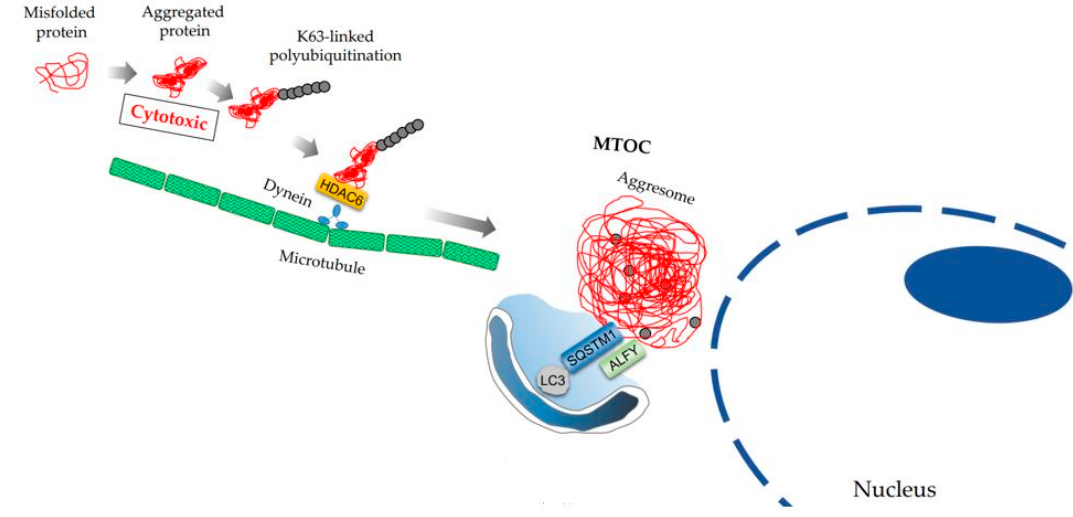
Figure 3. Transfer of aggregated proteins to aggresome in MTOC. Misfolded proteins build the cytotoxic aggregated protein. The aggregated protein, which is K63-polyubiquitinated, is trapped with HDAC6. The HDAC6 complex is transferred to the microtubule organizing center (MTOC) via dynein, resulting in aggresome. The autophagic adaptor proteins, SQSTM1 and ALFY, bind to aggresome to attract autophagosome membrane.